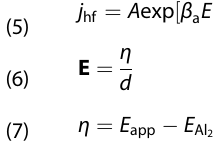
In the high fi eld model, the migration of ionic species across the oxide fi lm is considered the rate-limiting step for the metal oxidation rather than charge transfer. Mott and Cabrera derived the current expression, by de fi ning the potential drop within the oxide fi lm as the main driving force for the migration of ions 65 .